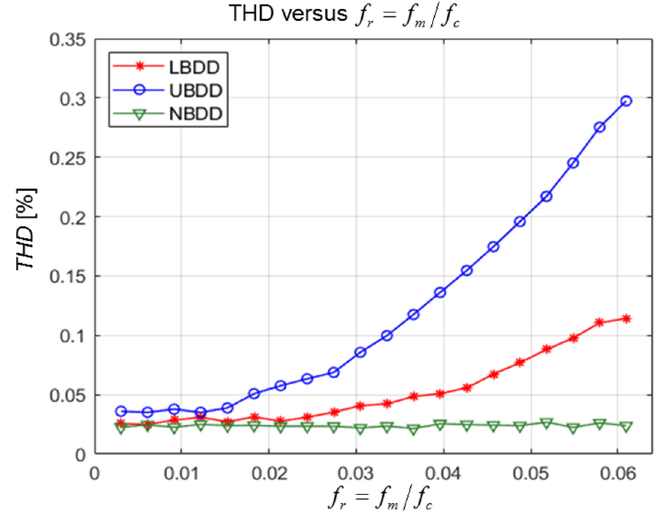
Figure 6. A comparison of the THD coefficients for three modulation methods, LBDD, NBDD, and UBDD, versus relative frequency f r = f m /f c .